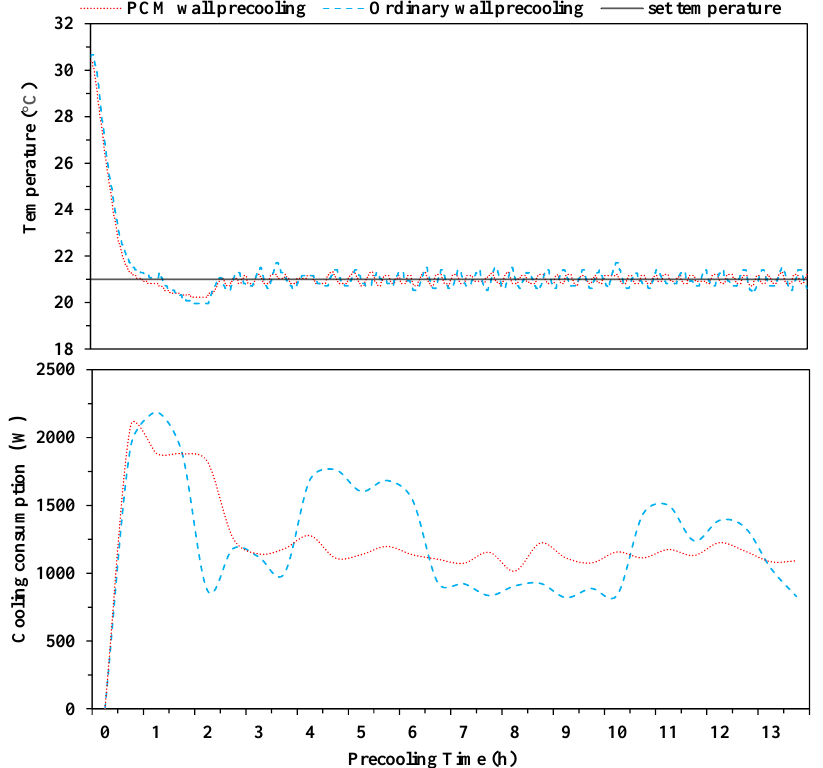
Figure 7. Room temperature and cold consumption during the precooling stage.